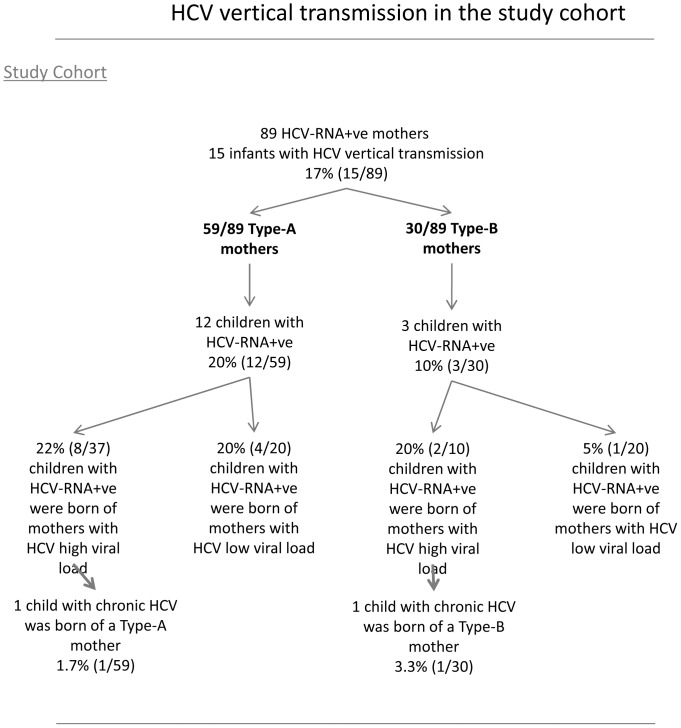
Description of HCV vertical transmission in the study cohort, showing the data for the 89 HCV-RNA+ve women (categorized into Type-A and Type-B mothers).